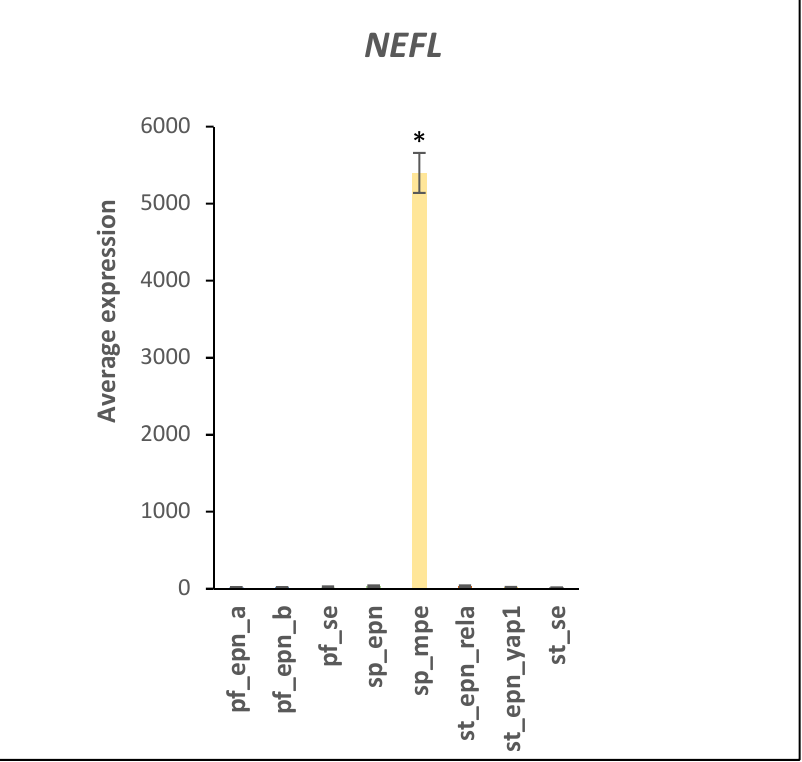
Figure 12. The NEFL gene is selectively overexpressed in SP_MPE (F = 1505.18, p = 7.05 × 10 − 170 ). * p < 0.001 by t -test, compared to all other groups. Dataset GSE64415. Located on chromosome 17 at 17q21.32, IGF2BP1 is a regulator of RNA stability and over-expression of IGF2BP1 is associated with tumor progression and poor prognosis in a variety of cancers [34]. Of all EPN subtypes, IGF2BP1 expression was selectively elevated in PF_EPN_A (F = 30.48, p = 1.66 × 10 − 28 ) (Figure 13). IGF2BP1 is a substrate of the E3 ligase